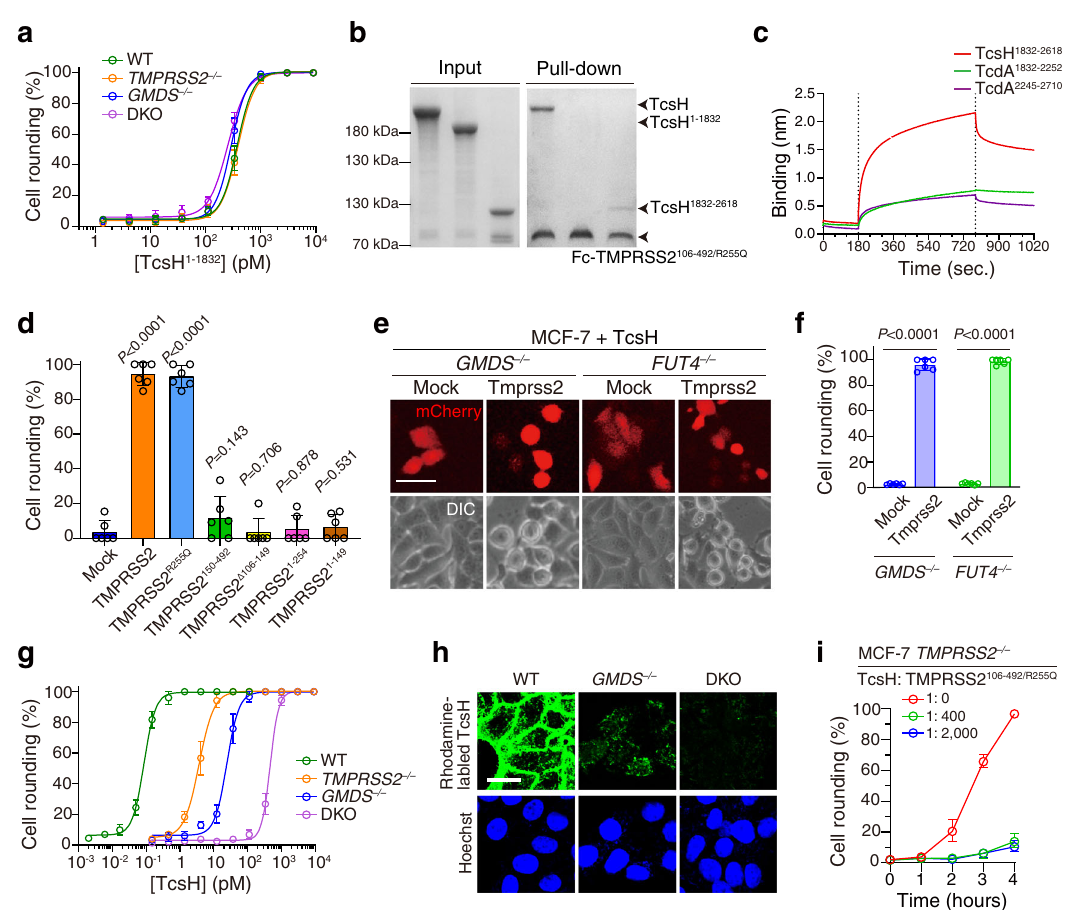
Fig. 4 | TMPRSS2-TcsH interaction is CROPs-dependent. a The MCF-7 WT, GMDS ‒ / ‒ , TMPRSS2 ‒ / ‒ ,and GMDS ‒ / ‒ / TMPRSS2 ‒ / ‒ (DKO)cellsshowedsimilarsensitivities to TcsH 1 – 1832 , measured by the cell-rounding assay. b The pull-down assay showed that TcsH, but not TcsH 1 – 1832 , binds to Fc-TMPRSS2 106-492/R255Q . TcsH 1832 – 2816 is weakly pulled down by Fc-TMPRSS2 106-492/R255Q . c BLI assays showed that TcsH 1832 – 2618 (1 μ M), but not TcdA 1832 – 2252 (1 μ M) or TcdA 2245 – 2710 (1 μ M), binds to Fc-TMPRSS2 106-492/R255Q . d Ectopic expression of TMPRSS2 and TMPRSS2 R255Q , but not others, enhanced the sensitivityofHeLacellstoTcsH.TheHeLacellsweretreatedwith2nMTcsHfor3h. Thepercentagesofround-shapedcellswerequanti fi edandplottedonthebarchart. Error bars represent mean ± s.d., n =6. two-sided Student ’ s t -test. e Overexpression